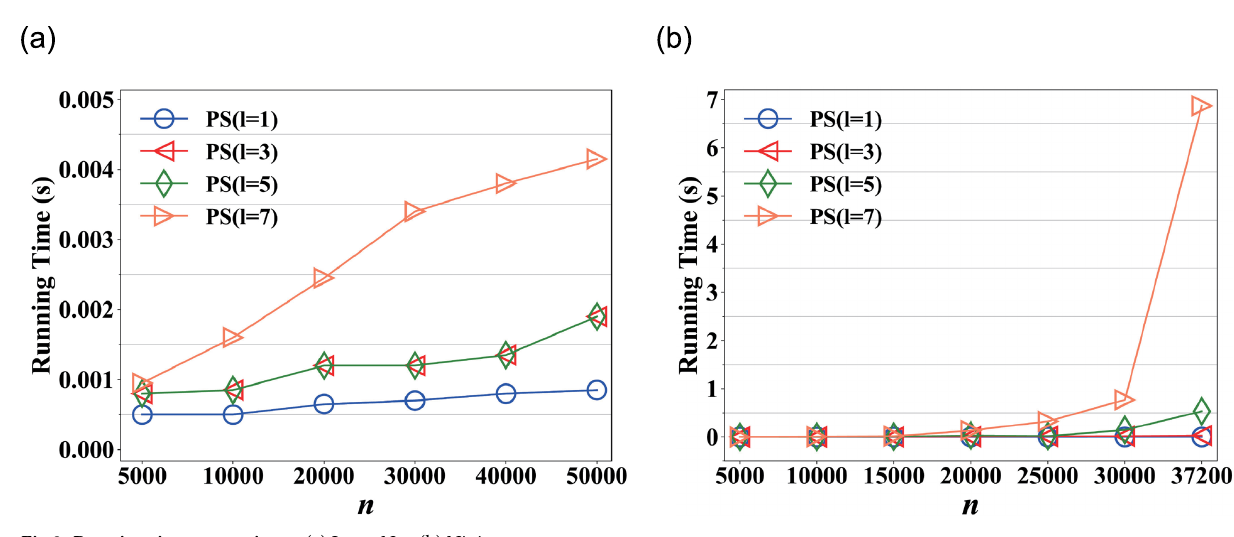
Fig 8. Running time on varying n . (a) ImageNet, (b)